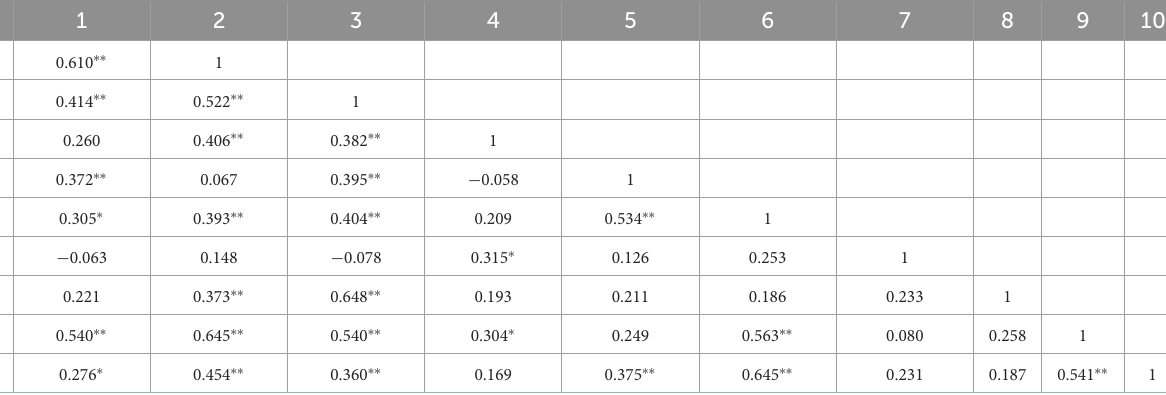
TABLE 2 Correlations between study variables.